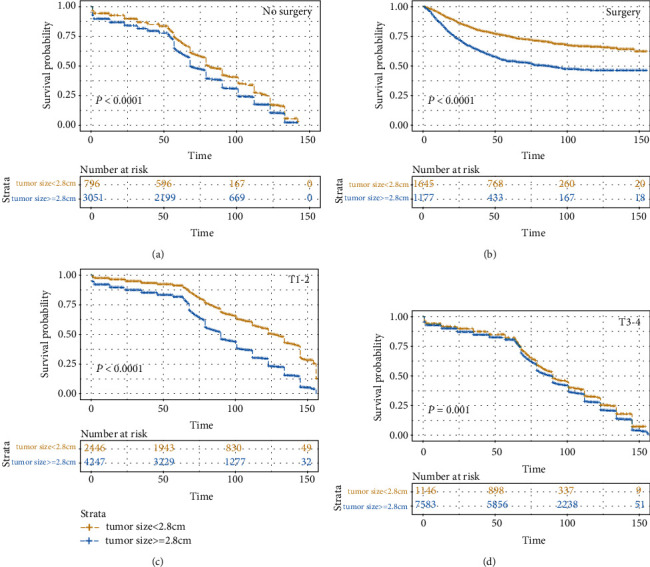
Kaplan-Meier survival curves compared tumor size less than 2.8 cm with tumor size greater than or equal to 2.8 cm: (a) in the no surgery group of the T1-2 stage, (b) in the surgery group of the T1-2 stage, (c) in the T1-2 stage, and (d) in the T3-4 stage.